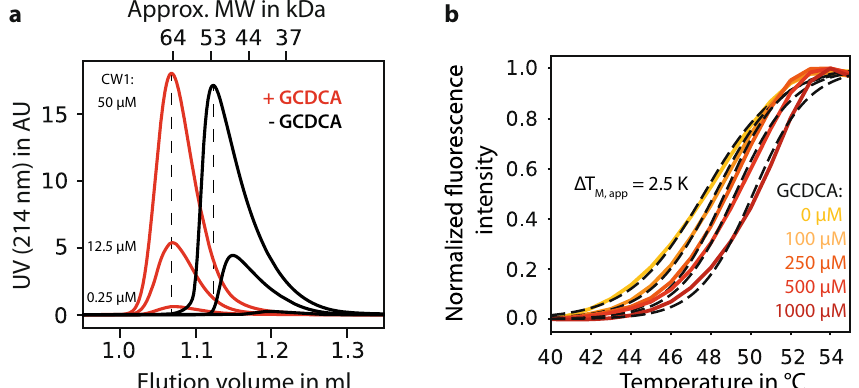
Fig. 3 The MNV P-domain readily dimerizes in presence of GCDCA. a Size-exclusion chromatography of the MNV CW1 P-domain in the presence (red curves) and absence (black curves) of GCDCA reveals a major change in elution behavior. The presence of saturating amounts of GCDCA (100 µ M) shifts the apparent molecular weight of the P-domain to that of the dimer (64 kDa) regardless of the protein concentration used. Six representative chromatograms are shown with a protein concentration range of 250 nM – 50 µ M. The disappearance of the protein concentration-dependent elution behavior indicates a dramatic stabilization of the dimeric protein in presence of its ligand. b The thermal stability of the CW1 P-domain increases with increasing GCDCA concentrations. Apparent CW1 melting temperatures were obtained by differential scanning fl uorimetry and curve fi tting to a Boltzmann model (dashed minimum threshold for signi fi cant CSPs, following a protocol we chemical shift perturbation (CSP) NMR experiments. CSPs of 13 C-methyl group signals of MIL proS V proS A labeled CW1 had used before 33 . The calculation provides a threshold value of 5.1 Hz (Figs. S16, S17). CSPs larger than this value are signi fi cant P-domain were monitored with increasing concentrations of with a con fi dence level of 99.99%. Signi fi cant CSPs not only map GCDCA using methyl TROSY spectra (Fig. 4). Based on the on the GCDCA binding pocket but also re fl ect long-range effects, assignment of 13 C-methyl signals of the P-domain saturated with indicating potential conformational changes at remote sites GCDCA 40 this titration also provided a partial assignment of (Fig. 4a, b). We then classi fi ed CSPs above the threshold of 5.1 Hz cross-peaks belonging to the apo-form of the P-domain as as “ small ” , values larger than 10 Hz and smaller than 20 Hz as described above. For the interpretation of CSPs reported as “ medium ” and CSPs larger than 20 Hz as “ large ” . “ Medium ” and Euclidian distances Δν Eucl 51 (Fig. S15) we fi rst calculated a